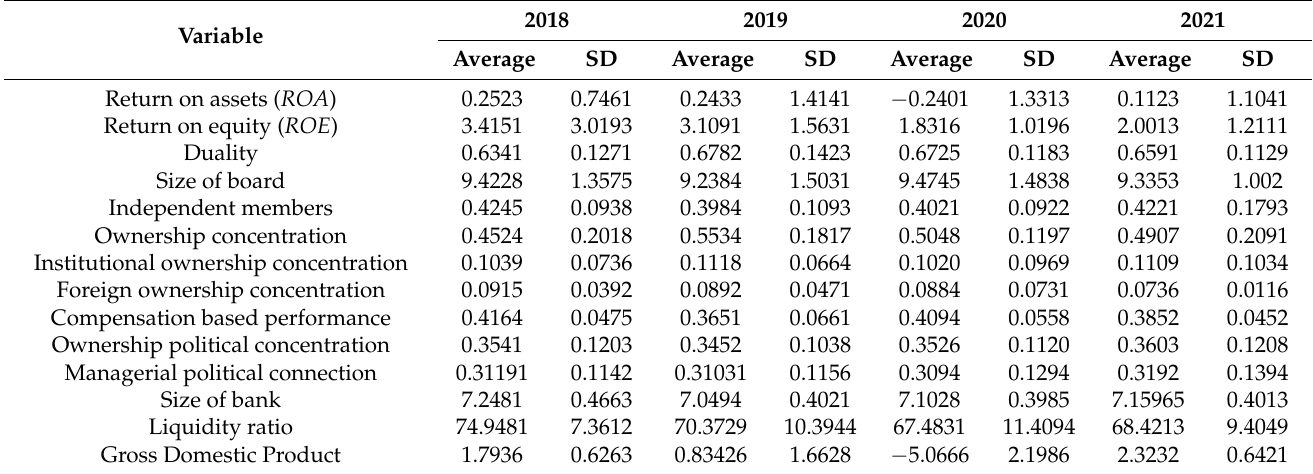
Table 3. Descriptive Statistics.